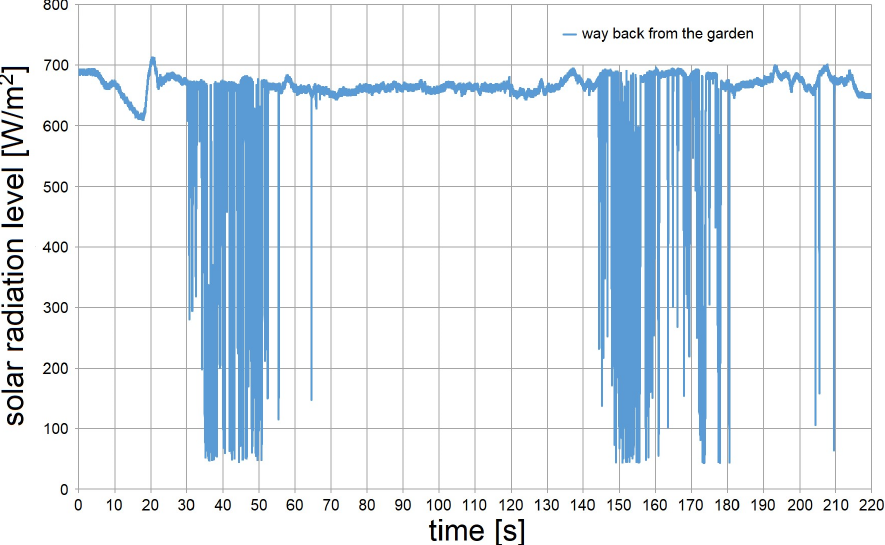
Figure 20. λ for trip from botanical garden to sports hall.